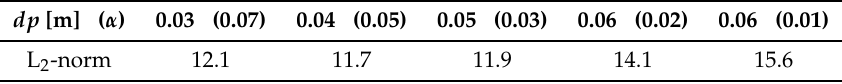
Table 3. L 2 -norm for the average profile of u for various combinations of dp and α